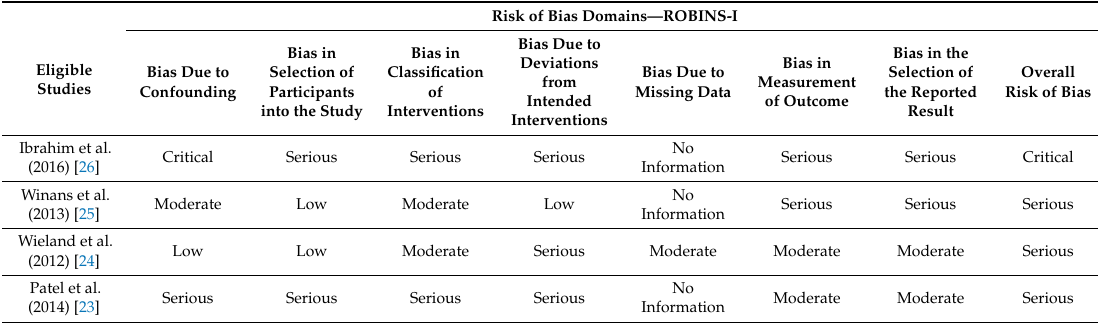
Table 3. Risk of bias non-randomised